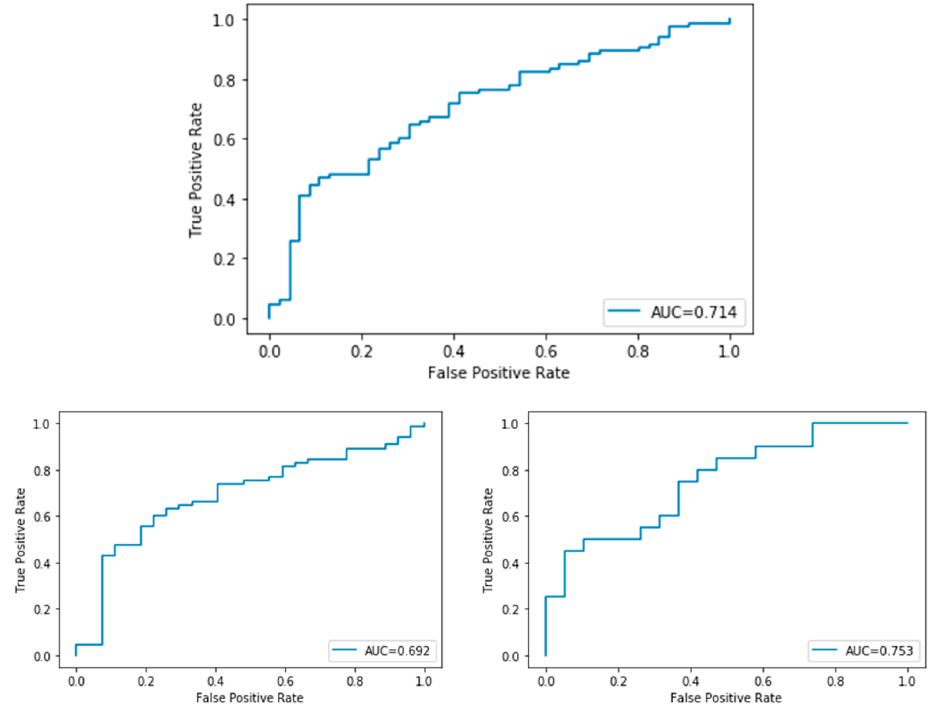
Figure 5. Phase 4: classification on testing set with the highest test AUC model. Top: validation AUC ROC. Bottom left: ROC curve on BRCA mut cases. Bottom right: ROC curves on BRCA WT cases.